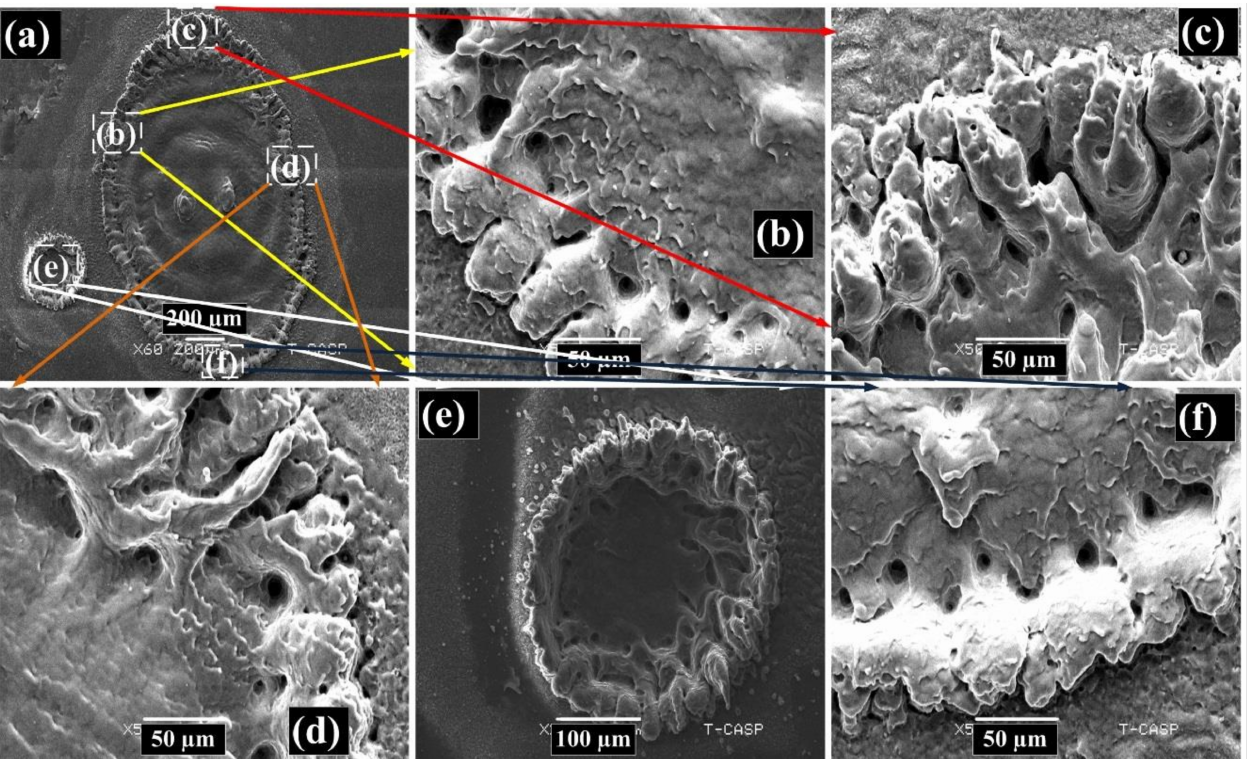
Figure 12. SEM micrographs of the laser-ablated areas of Mg showing the variation in surface morphology under an ambient environment of Ne and a constant pressure of 5 Torr for a laser irradiance of 2.0 GW/cm 2 in the field-free case, where ( a ) the surface structure at the boundaries of the laser-ablated crater of the Mg alloy, ( b ) the cones and irregularly sized cavities at the left side, ( c ) the cones and irregularly sized cavities at the upper side, ( d ) the cones and irregularly sized cavities at the right side of laser-ablated crater, ( e ) small circular crater near the large laser-ablated crater, ( f ) Micro-sized ridges and cavities can be observed at the lower outer boundary of the